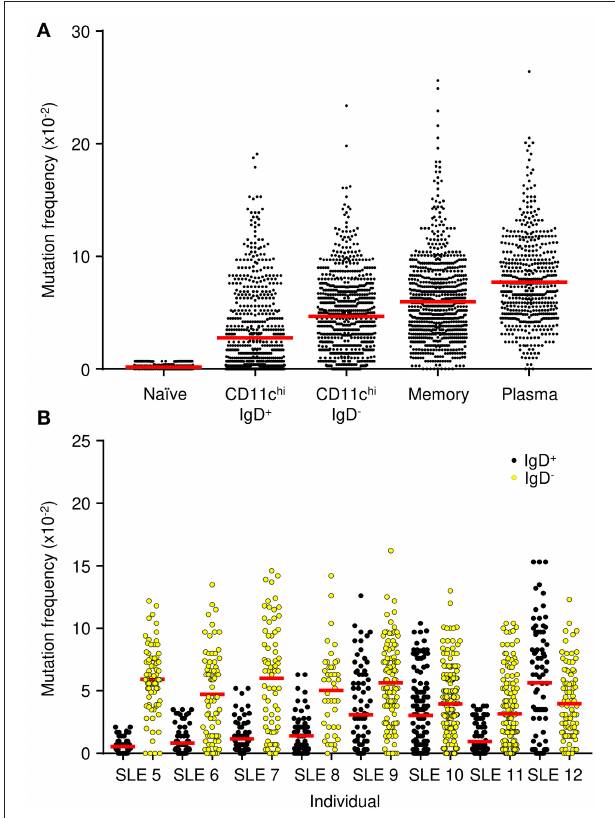
FIGURE 7 | IgH V-gene mutation frequency. (A) Combined frequencies for each cell population from eight SLE patients. (B) Frequency for the CD11c hi IgD + (black) and CD11c hi IgD − (yellow) B cells from each individual SLE patient. Dots represent the mutation frequency for each IgH sequence, red line represents the average frequency of the